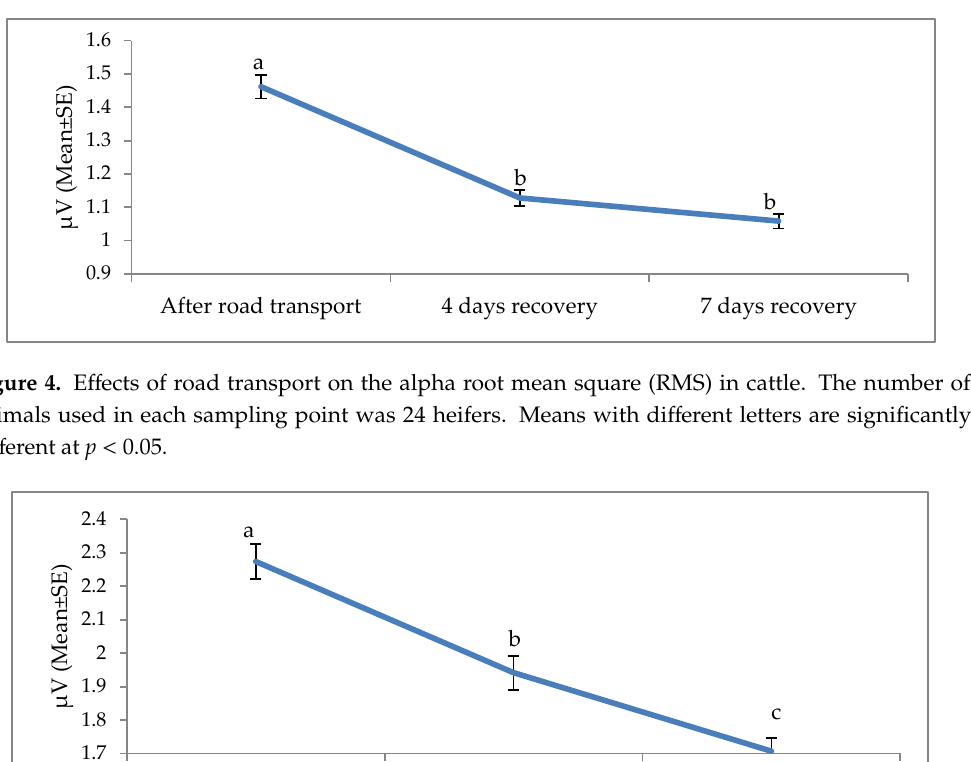
Figure 3. Effects of sea and road transport on serum amyloid-A (SAA) levels in cattle. The number of animals used in each sampling point was 24 heifers. Means with different letters are significantly different at p < 0.05.